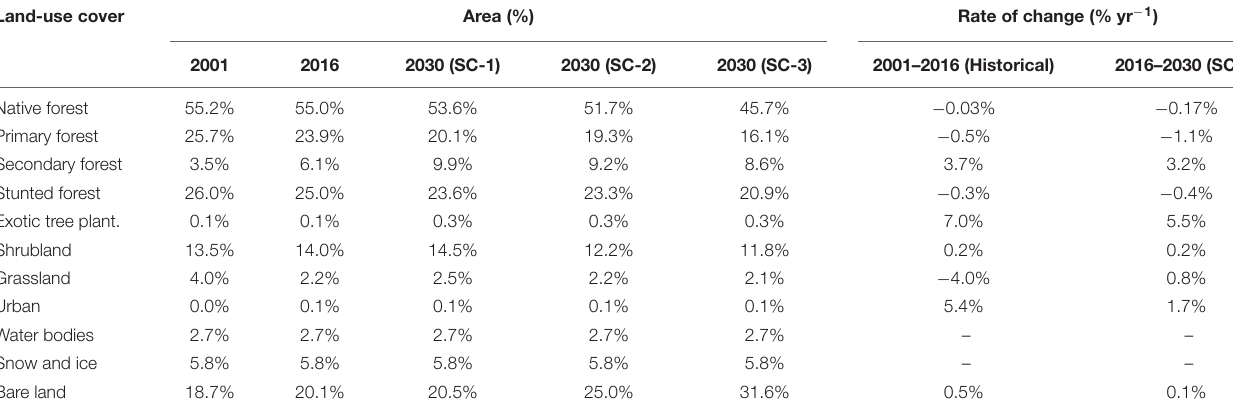
TABLE 3 | Land cover in the Puelo River Basin in 2001, 2016 and 2030 (under the three scenarios). Land-use cover